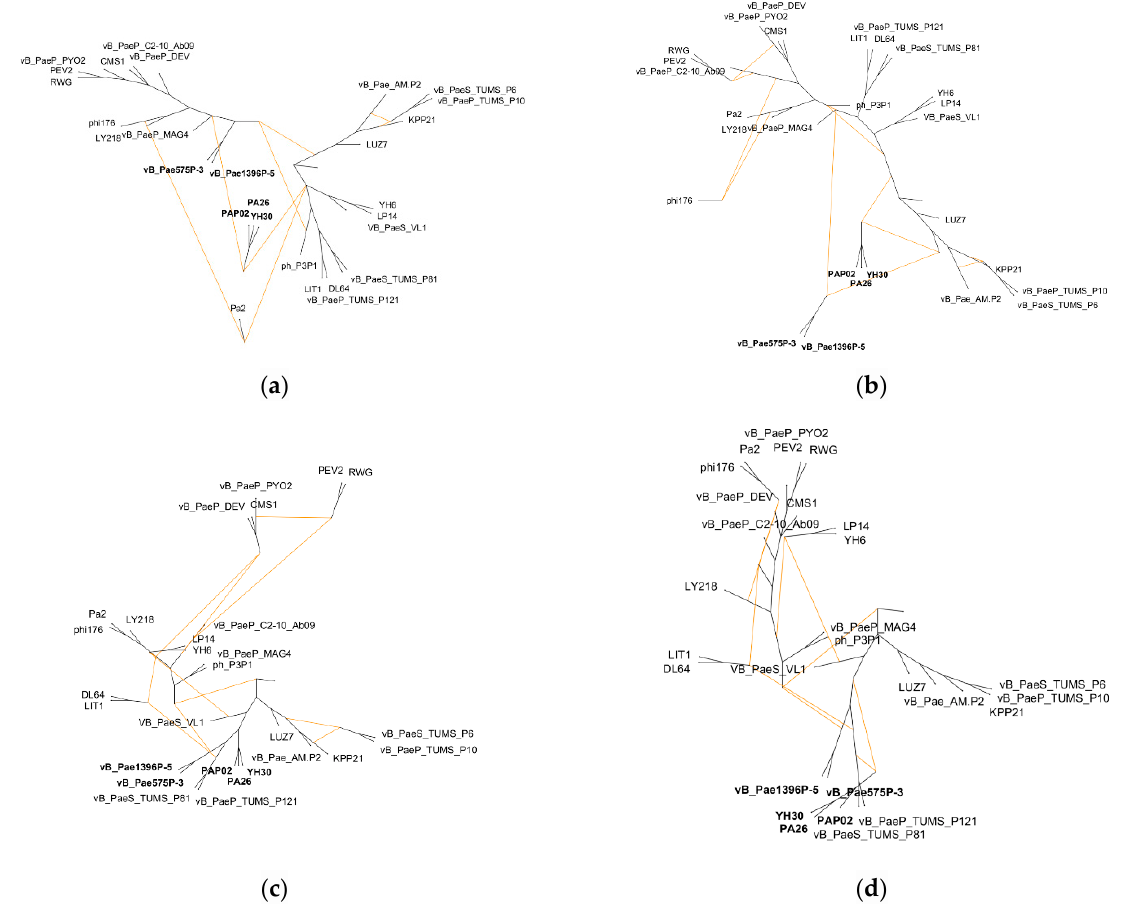
Figure 4. Hybridization network analysis. Each conflicted pair of trees involves the whole-genome minus variable region tree and one of the domain trees: ( a ) GrpE tree; ( b ) GDSL-like lipase/acylhydrolase tree; ( c ) pyocin knob domain tree; ( d ) C-terminal end tree. Reticulate nodes formed by orange lines indicate the recombinant phages. The most crucial viral taxa are presented in bold.